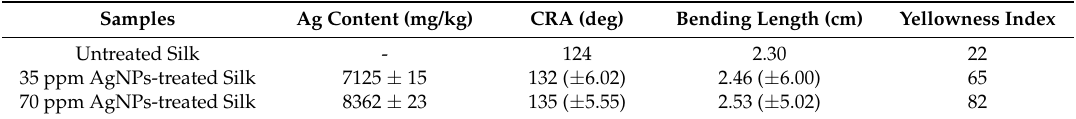
Table 3. Physical properties of